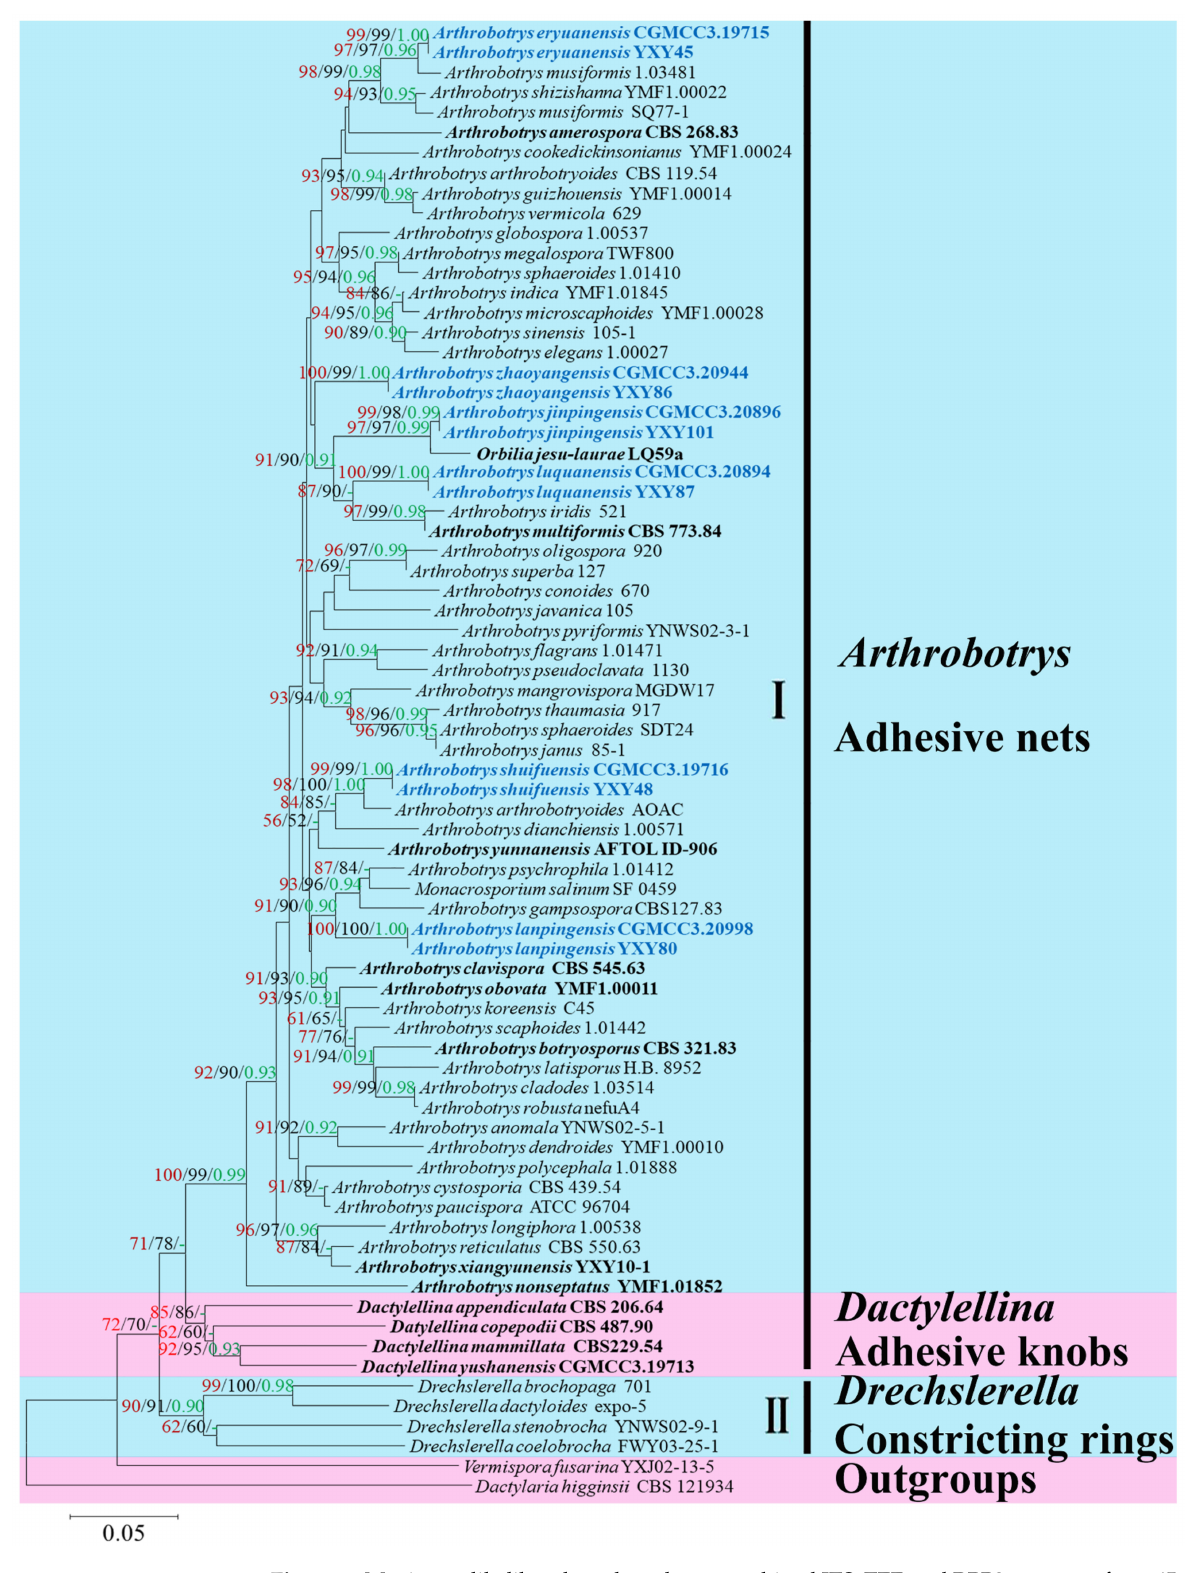
Figure 1. Maximum likelihood tree based on a combined ITS, TEF, and RPB2 sequence from 65 species of Orbiliaceae nematode-trapping fungi. Bootstrap support values for maximum likelihood (red) and maximum parsimony (black) greater than 50% and Bayesian posterior probabilities values (green) greater than 0.90 are indicated above the nodes. The new isolates are in blue; type strains are in bold. The tree is rooted by Vermispora fusarina YXJ13-5 and Dactylaria higginsii CBS